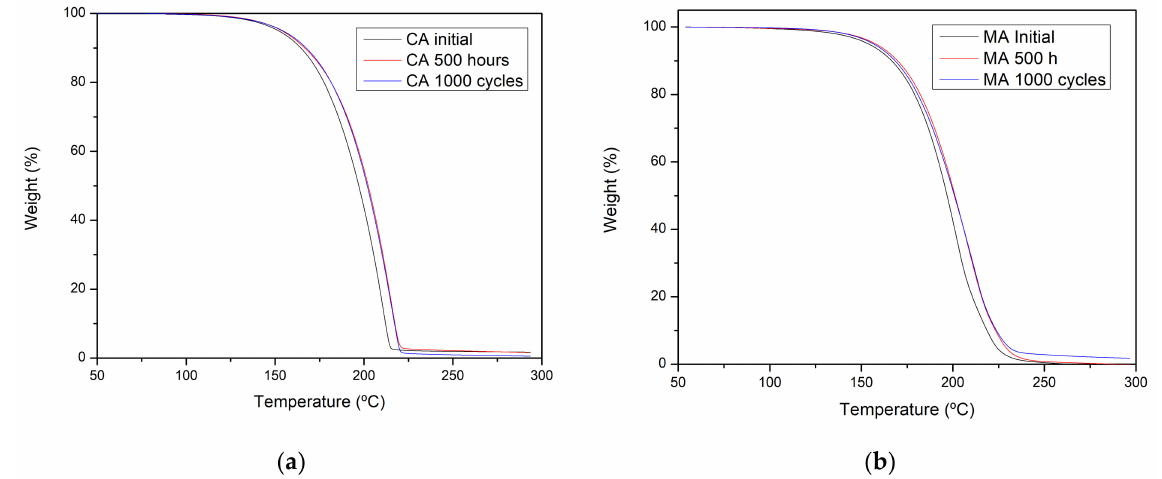
Figure 5. TGA results: ( a ) Capric acid thermal and cycling stability, ( b ) Myristic acid thermal and cycling